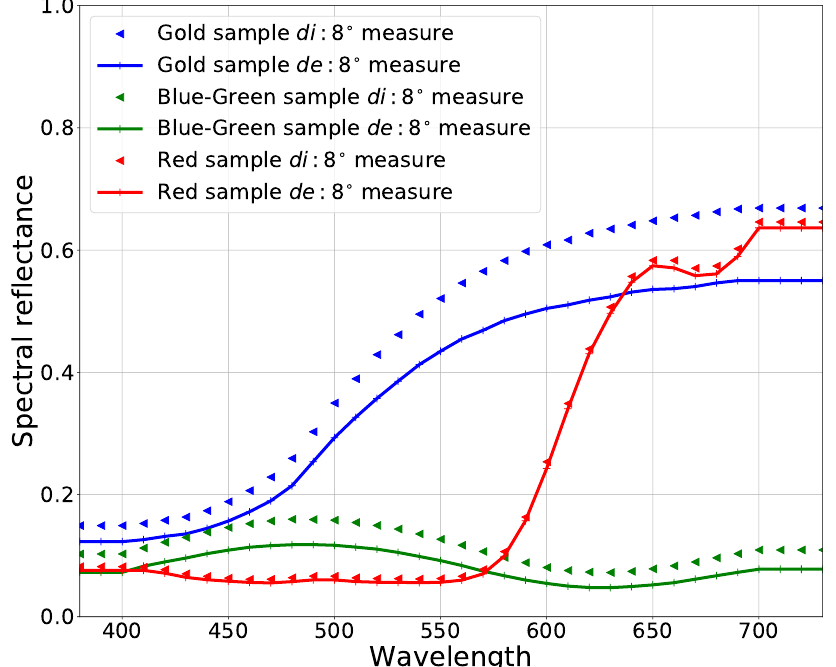
Figure 2. Spectral reflectance measurements using the X-rite SP64 spectrophotometer (with specular included and excluded measurement